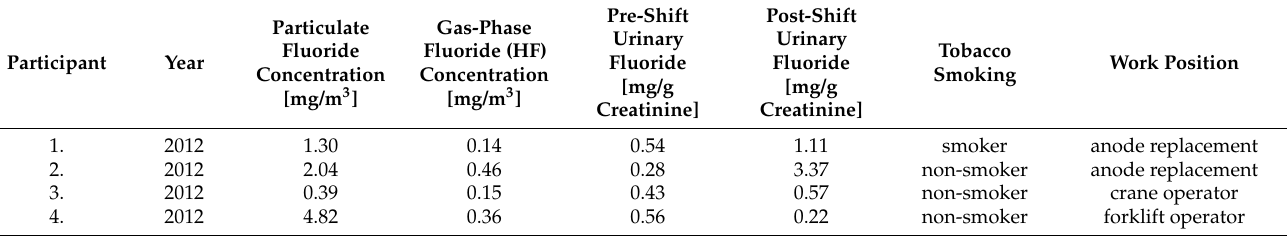
Table A1. Data on study participants and their occupational exposure (particulate and gas-phase fluoride concentration detected by personal sampling), urinary fluoride biological monitoring (pre- and post-shift urinary fluoride), tobacco smoking habit, and work